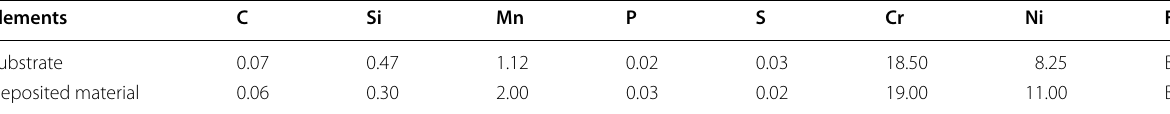
Table 1 Chemical compositions (wt%) of substrate and deposited material Elements C Si Mn Fe Substrate Deposited material